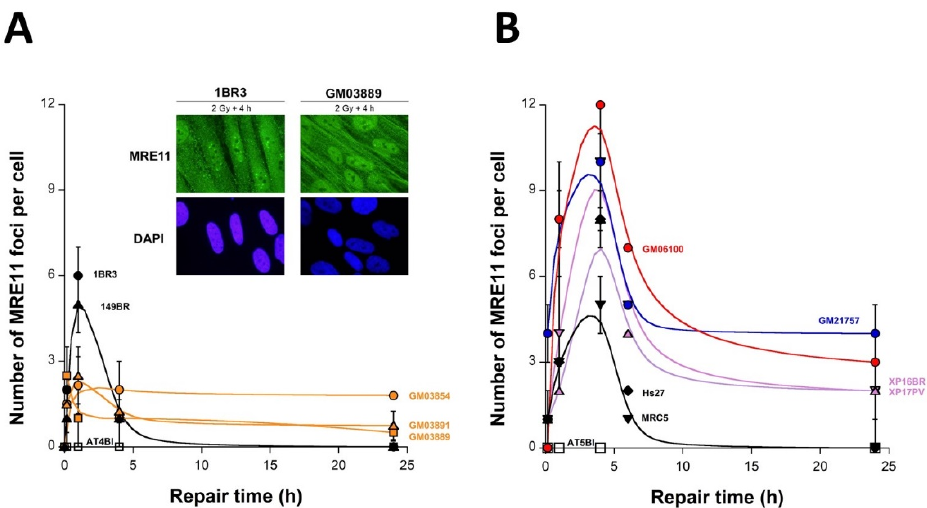
Figure 5. Kinetics of the appearance/disappearance of MRE11 foci in USH1 fibroblasts: The number of MRE11 foci was plotted against post-irradiation time. Data were obtained from the radioresistant controls 1BR3 and 149BR, the hyper-radiosensitive ATM -mutated AT4BI, and the three USH1 (GM03854, GM03889, and GM03891) fibroblast cell lines ( A ), and from the radioresistant controls MRC5 and Hs27, the hyper-radiosensitive ATM -mutated AT5BI, the HD (GM21757), the TSC (GM06100), and two XPD (XP16BR and XP17PV) fibroblast cell lines ( B ). Each plot represents the mean ± SEM of three replicates. Data were fitted to Bodgi’s formula [36]. The insert shows a representative illustration of DAPI-stained nuclei and MRE11 foci observed at 4 h post-irradiation in the indicated cell lines.